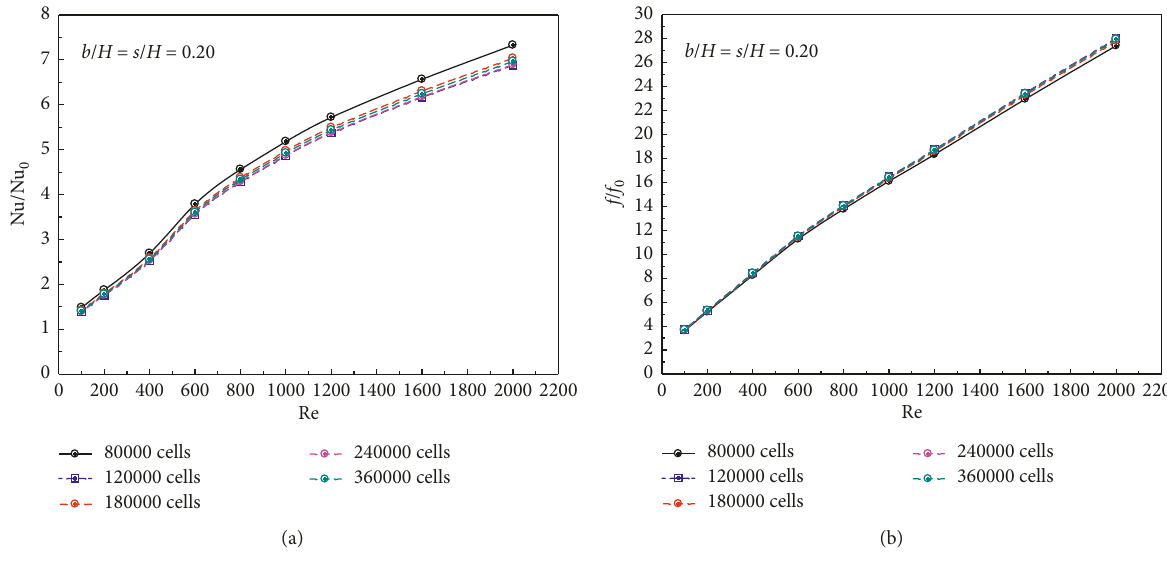
Figure 5: Grid independence for (a) Nusselt number ratio and (b) friction factor ratio.